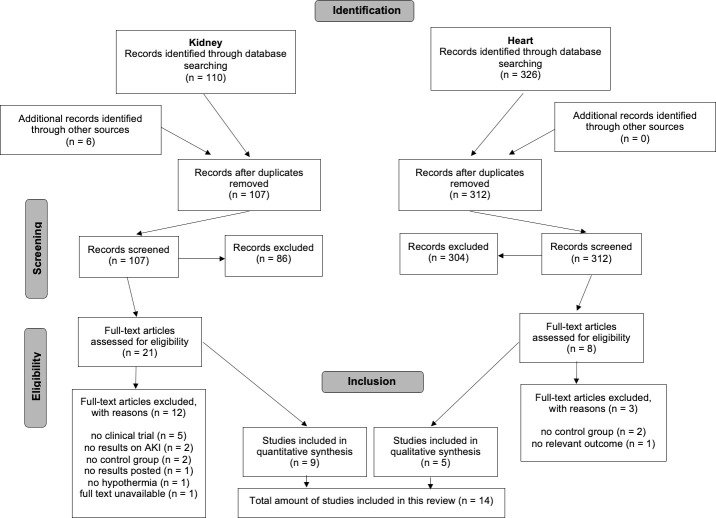
PRISMA chart of the identification and selection of studies regarding short-term renal and myocardial function.